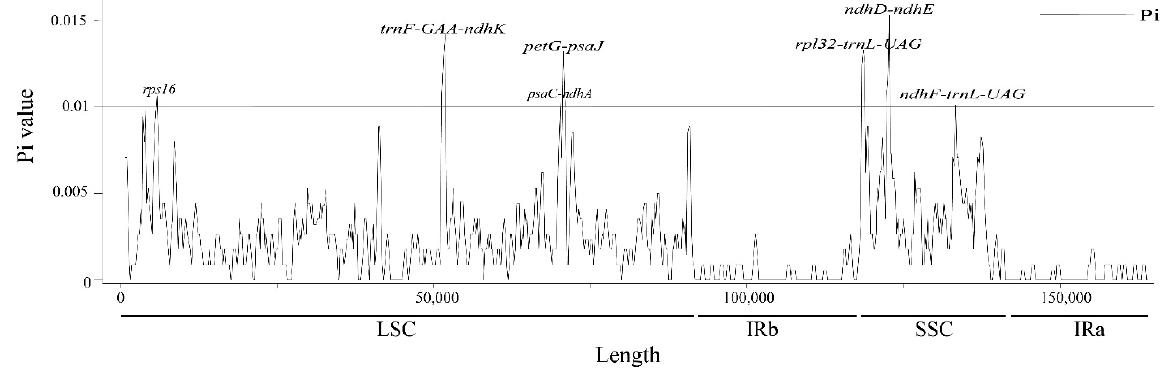
Figure 3. Sliding window analysis of the whole chloroplast genome nucleotide diversity (Pi) of the six Magnoliaceae species.